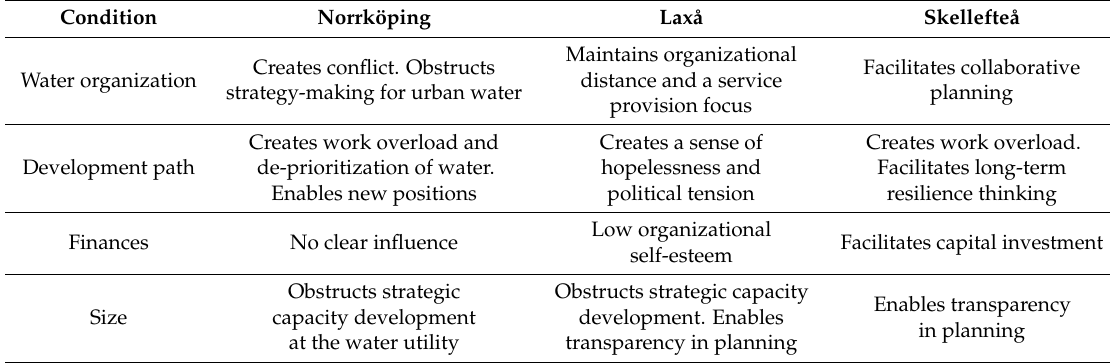
Table 4. Influence of the tested institutional and socio-economic conditions on the strategy-making ability for urban